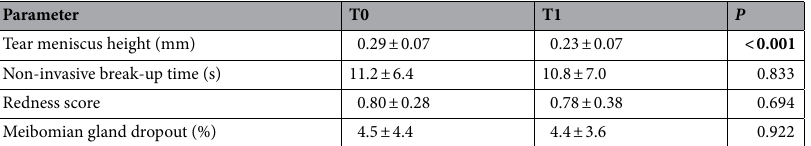
Table 1. Noninvasive ocular surface parameters obtained with Keratograph 5 M in healthy subjects before (T0) and after 8 h of continuous face mask wearing (T1). mm millimetres; s seconds. Bold values denote statistical significance at the P < 0.05